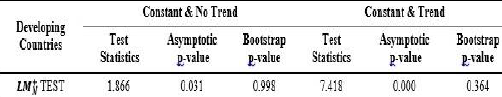
Table 7: Westerlund and Edgerton LM Panel Cointegration Test Analysis